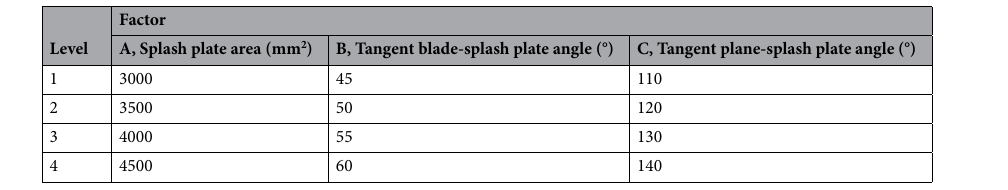
Table 1. Factor level